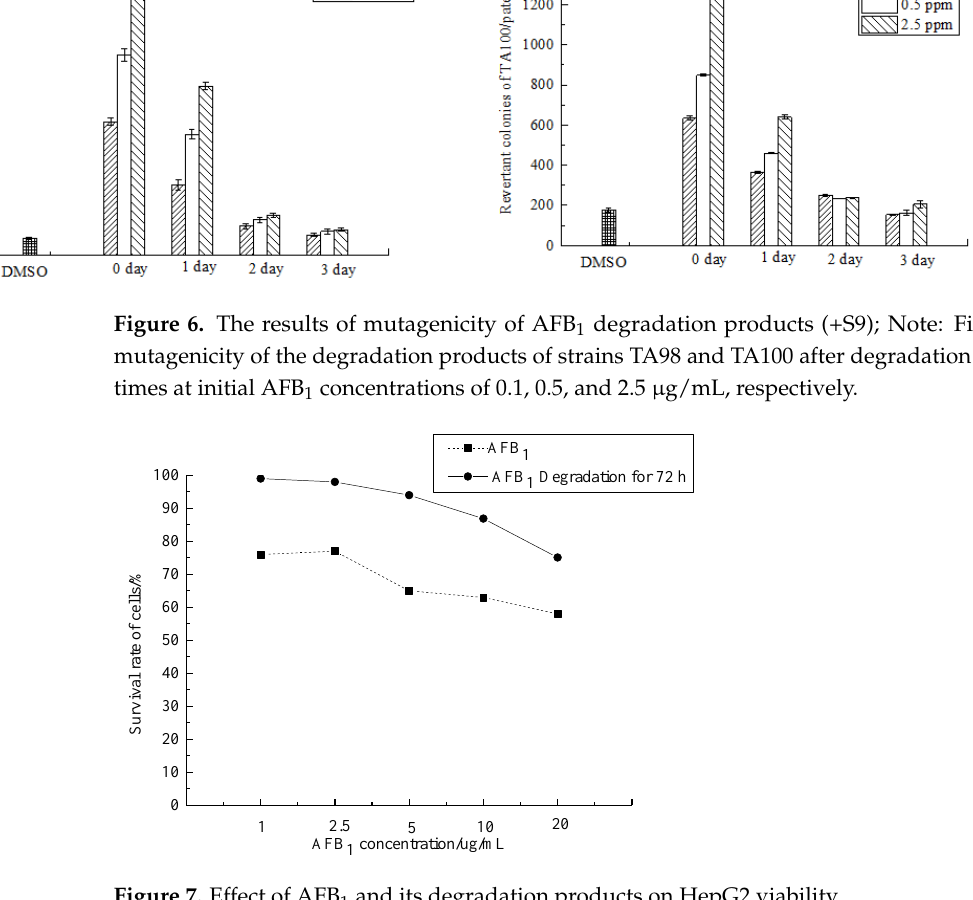
Figure 6. The results of mutagenicity of AFB 1 degradation products (+S9); Note: Figure ( a , b ) is mu- tagenicity of the degradation products of strains TA98 and TA100 after degradation for different times at initial AFB 1 concentrations of 0.1, 0.5, and 2.5 μg/mL, respectively.